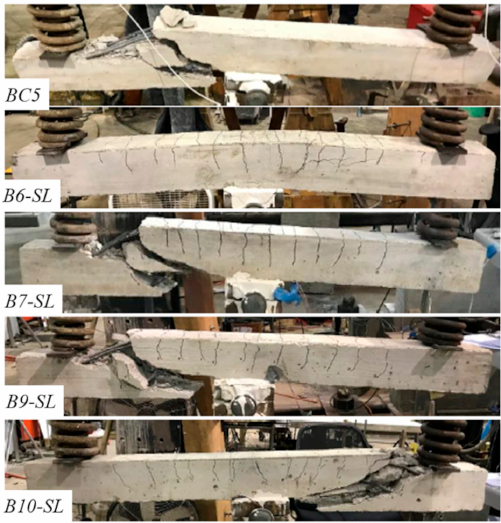
Figure 12. Beam series II failures.